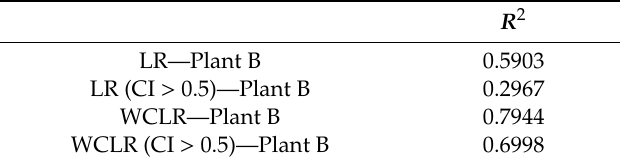
Table 5. Correlation coe ffi cient values of LR, LR (CI > 0.5), WCLR, WCLR (CI > 0.5)—Plant B.